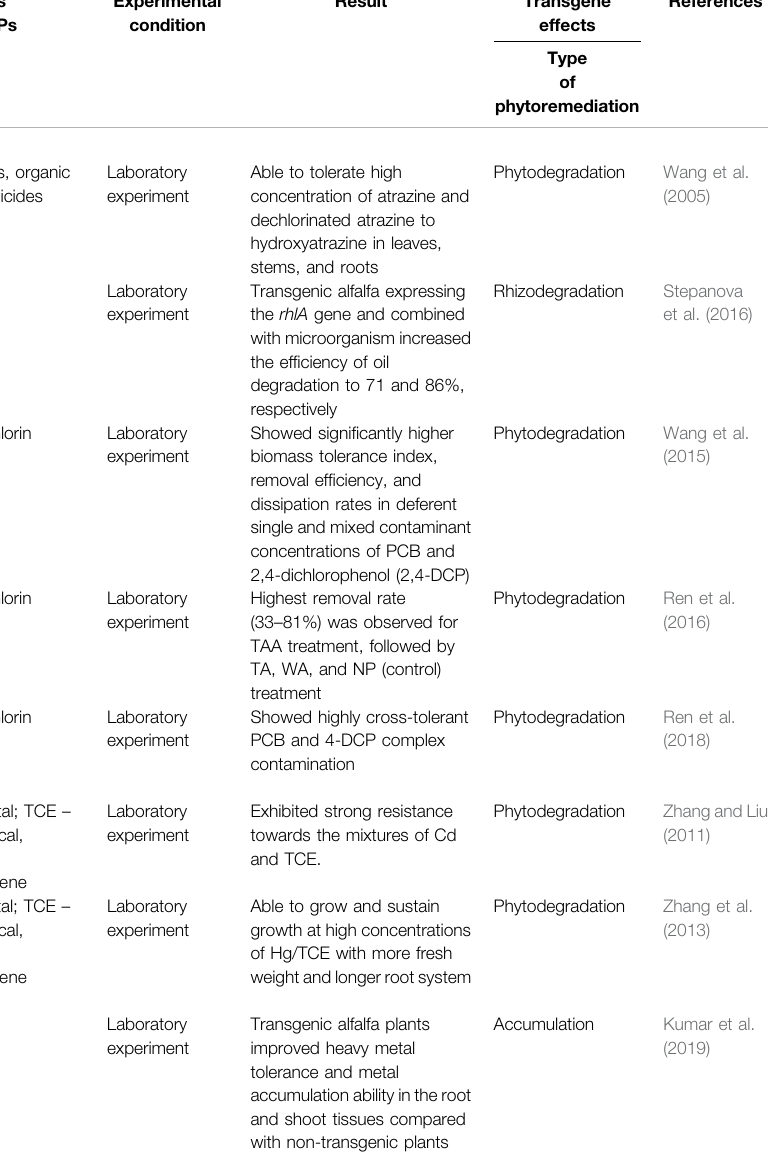
TABLE 1 | Transgenic alfalfa plants for enhancement of phytoremediation ef fi ciency Target